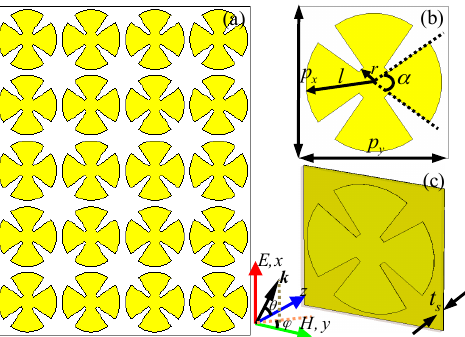
Figure 1. The designed multi-band metamaterial absorber ( MMA): ( a ) 2D-array structure; ( b , c ) front view and perspective view of the unit cell structure, respectively.